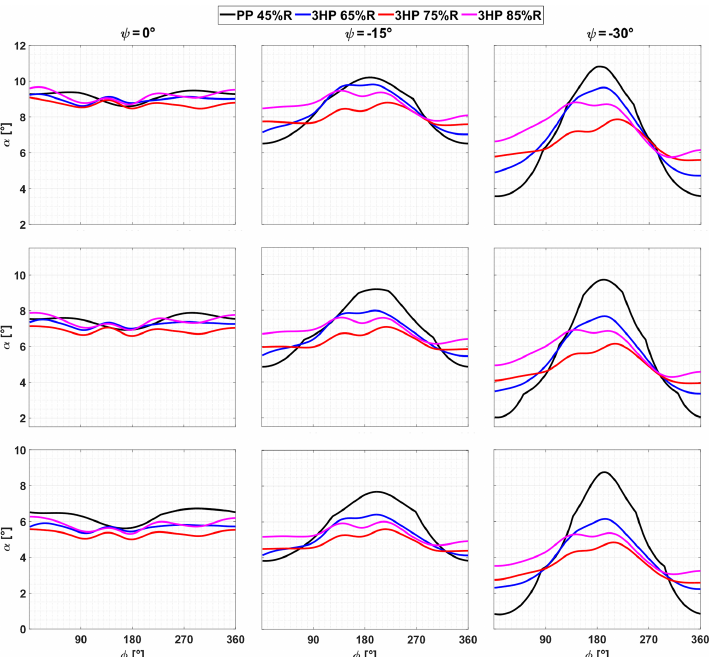
Figure E1. AoA results from the pressure tap and three-hole-probe approaches. In columns are shown the yaw angles: ψ = 0 ◦ , ψ = − 15 ◦ and ψ = − 30 ◦ . In rows are shown the pitch angles: θ = − 2 ◦ , θ = 0 ◦ and θ = 2 ◦